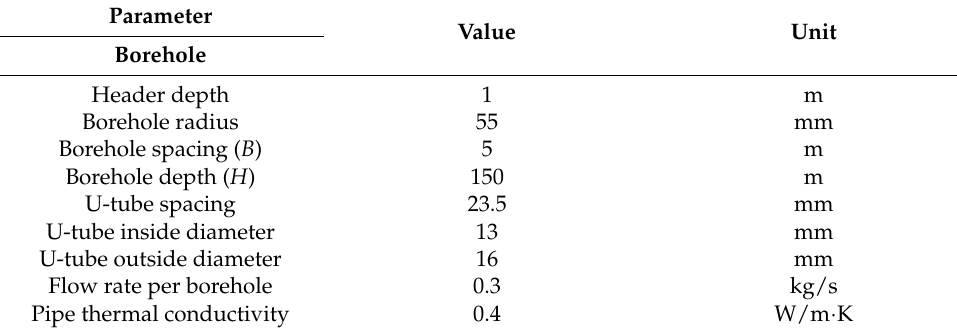
Table 3. Parameters of GCHP system